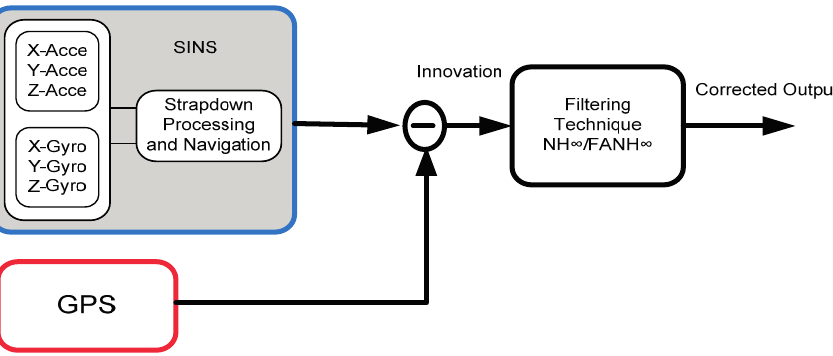
Figure 2. Aided SINS/GPS system